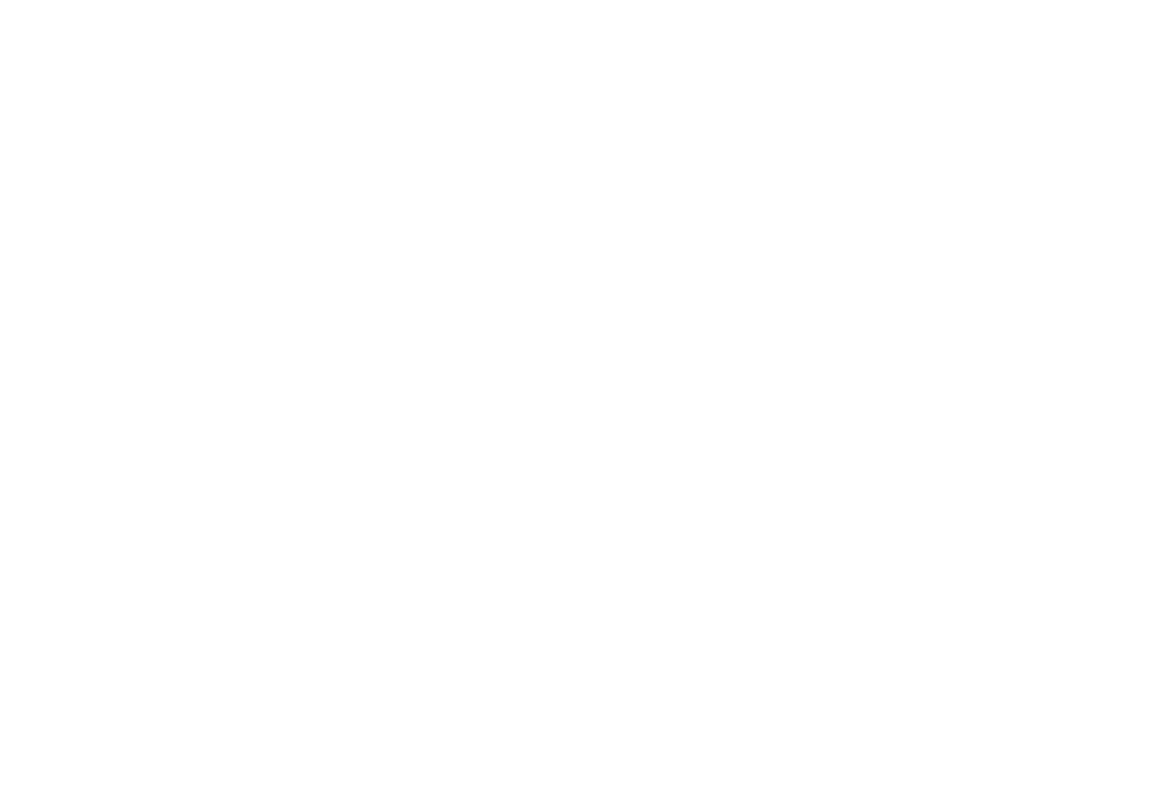
PLOS ONE | https://doi.org/10.1371/journal.pone.0233216 May 11,